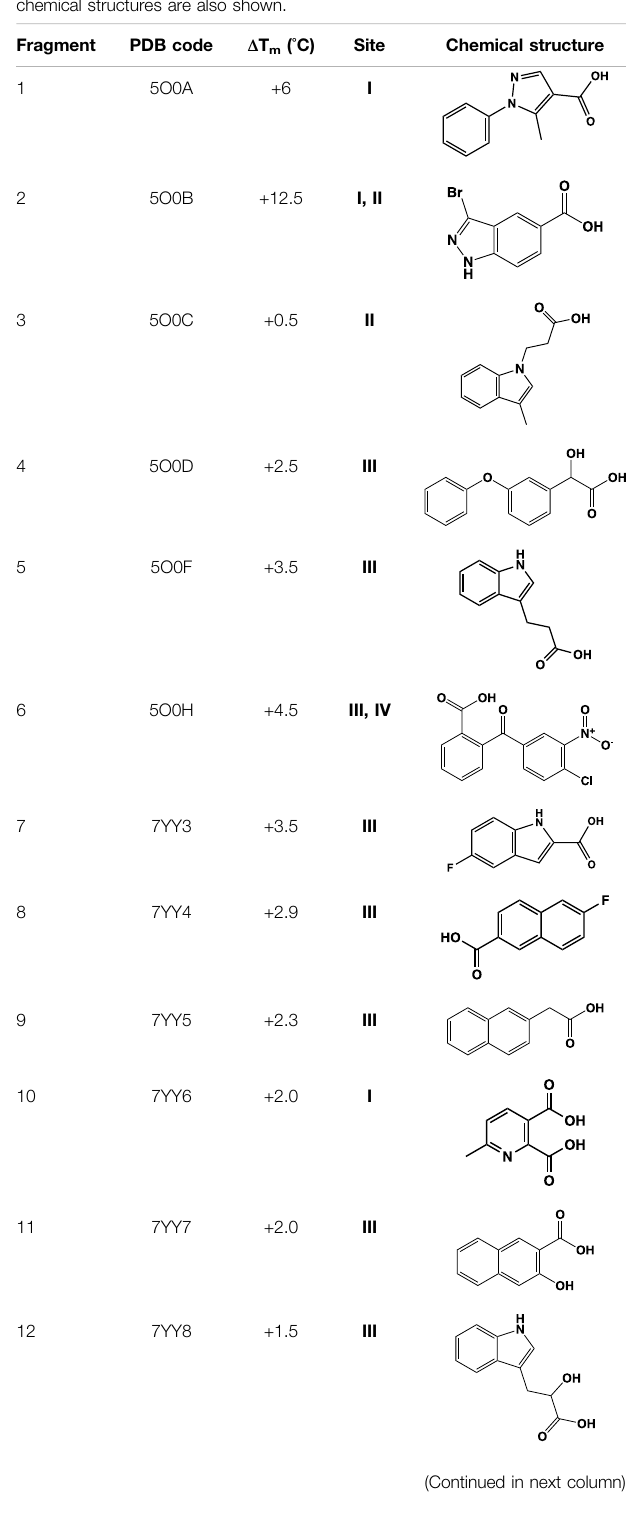
TABLE 1 | Summary of fragment hits identi fi ed on M. abscessus PPAT shown along with corresponding thermal shift values and binding sites. Fragment chemical structures are also shown.